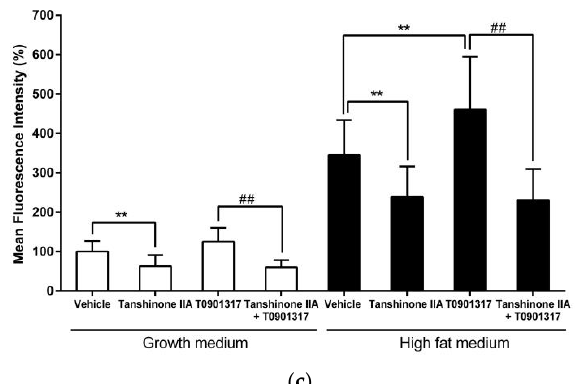
Figure 8. Effects of tanshinone IIA on lipid-droplet accumulation in HepG2 cells. HepG2 cells were pretreated with vehicle (0.1% DMSO) or tanshinone IIA (10 μM) for 1 h followed by treatment with T0901317 (1 μM) in ( a ) growth medium or ( b ) high-fat medium. The lipid droplets were stained by BODIPY493/503 fluorescent dye (green), and nuclei were stained by DAPI (blue). Stained cells were observed and photographed with a confocal microscope. The scale bar is 10 μm. ( c ) Quantification of lipid droplets accumulation. The mean fluorescent intensities of the lipid droplets per cell were quantified in 25 – 30 randomly selected fields (>200 cells) from three independent replicates, and the data represent the mean ± SD from three independent experiments. ** p < 0.01 indicates significant differences compared to the vehicle-treated cells. ## p < 0.01 indicates significant differences compared to the cells treated with T0901317 alone.